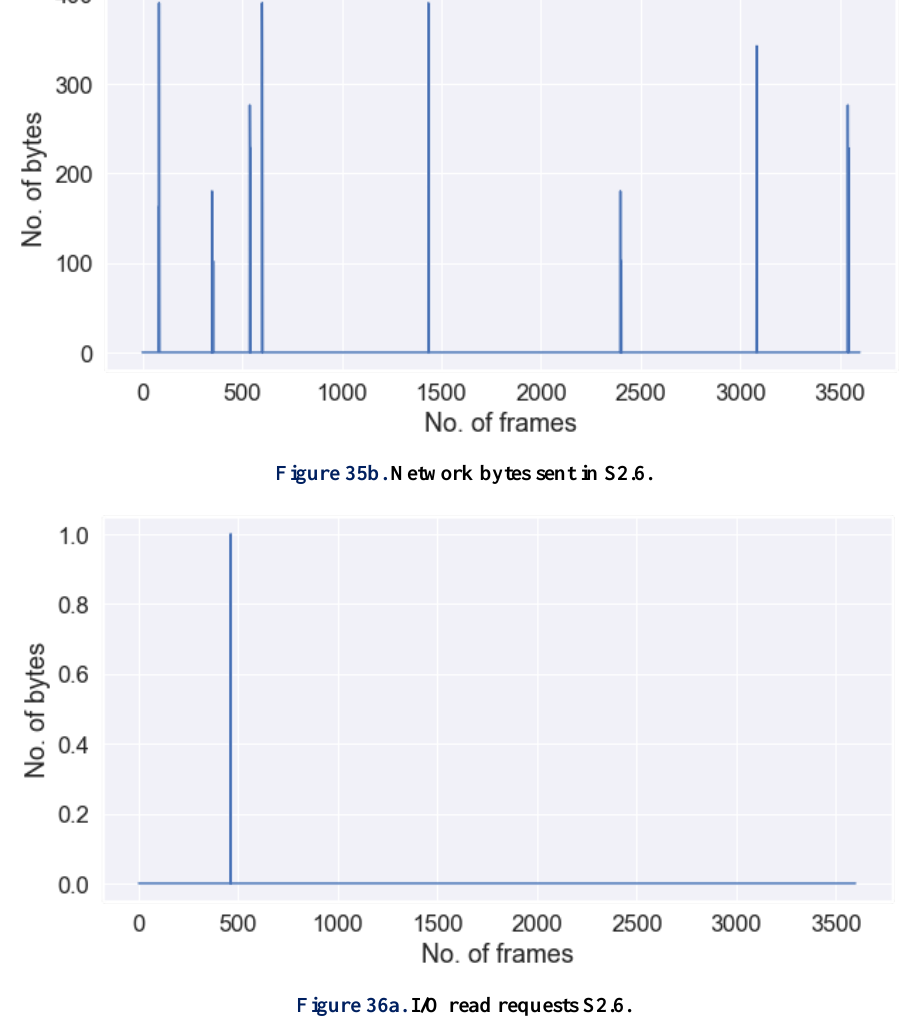
Figure 36a. I/O read requests S2.6.